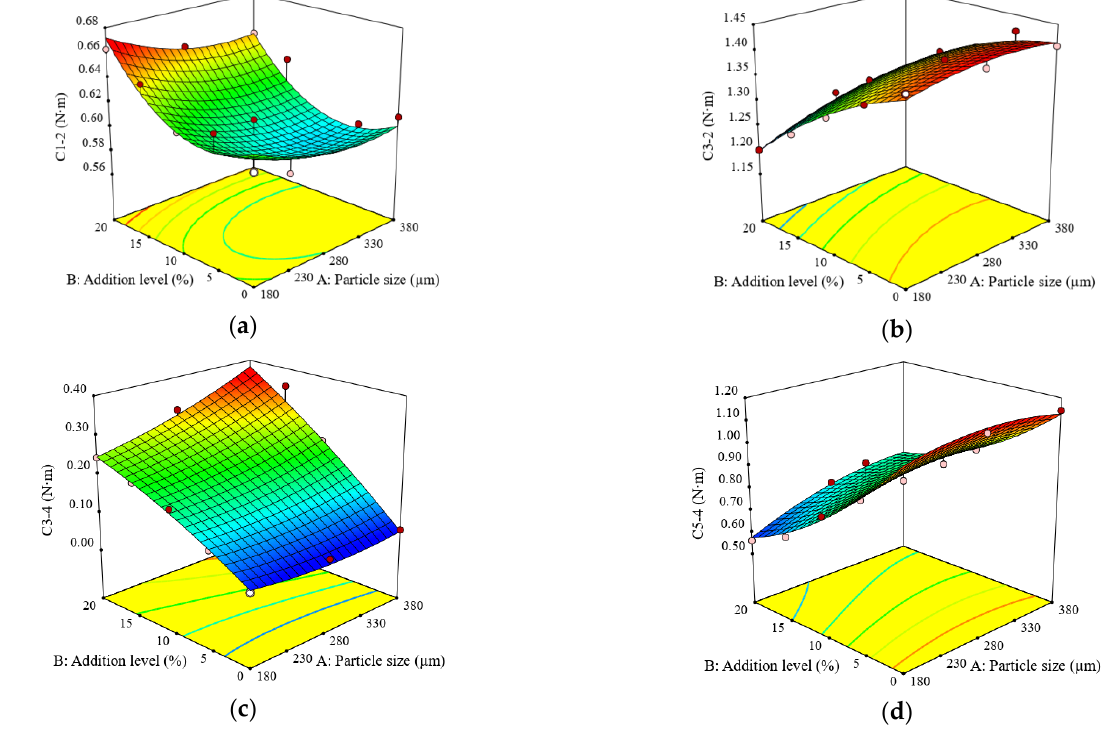
Figure 2. 3D response surface graphic presenting the effect of quinoa flour particle and addition level on: ( a ) protein weakening (C1-2); ( b ) starch gelatinization (C3-2); ( c ) cooking stability (C3-4); ( d ) starch retrogradation (C5-4).